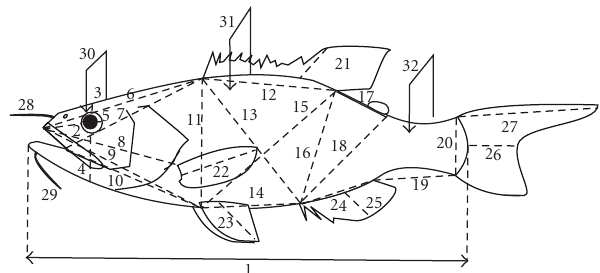
Figure 1: Diagram showing morphometric characters measured in examined fishes. M1 standard length; M2 distance from tip of snout to anterior margin of the eye; M3 perpendicular distance from upper edge of orbit to dorsal profile; M4 perpendicular distance from lower margin of orbit to ventral profile; M5 maximum diameter of orbit; M6 distance from tip of snout to origin of dorsal fin; M7 distance from tip of snout to origin of dorsal fin; M8 distance from tip of snout to dorsal point of insertion of pectoral fin; M9 distance from tip of snout to dorsal point of insertion of pelvic fin; M10 distance from tip of snout to dorsal point of insertion of pelvic fin; M11 distance from origin of dorsal fin to dorsal point of insertion of pelvic fin; M12 length of base of dorsal fin; M13 distance from origin of dorsal fin to origin of anal fin; M14 distance from origin of pelvic fin to origin of anal fin; M15 distance from terminus of base of dorsal fin to origin of pelvic fin; M16 distance from terminus of base of dorsal fin to origin of anal fin; M17 distance from terminus of base of dorsal fin to origin of adipose fin; M18 distance from terminus of base of adipose fin to origin of anal fin; M19 distance from terminus of base of anal fin, including to base of caudal fin; M20 width of caudal fin at its base; M21 length of longest dorsal fin ray; M22 length of longest pectoral fin ray; M23 length of longest pelvic fin ray; M24 length of base of anal fin; M25 length of longest anal fin ray; M26 distance from center of caudal peduncle to distal margin of caudal fin; M27 length of longest caudal fin ray; M30 interorbital width; M31 greatest width if central part of body; M32 width of middle of caudal